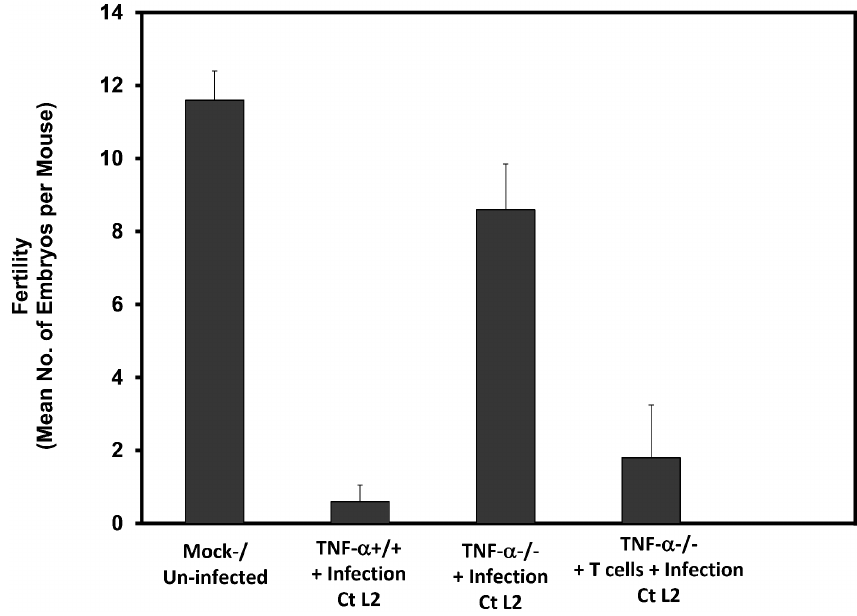
Fig 8. Role of T cell-derived TNF-alpha in chlamydial-induced infertility. Groups of female mice (TNF- alpha -/- , controls TNF-alpha +/+ , and TNF-alpha -/- that received 10 7 purified T cells from TNF-alpha ++ mice) were infected intravaginally with C . trachomatis L2 (WT-L2), as described in the Materials and Methods section. Infected and noninfected control mice were mated and scored for pregnancy and no. of pups. The plotted data are the means (SEM) for groups from 2 independent experiments with 6 mice per experimental